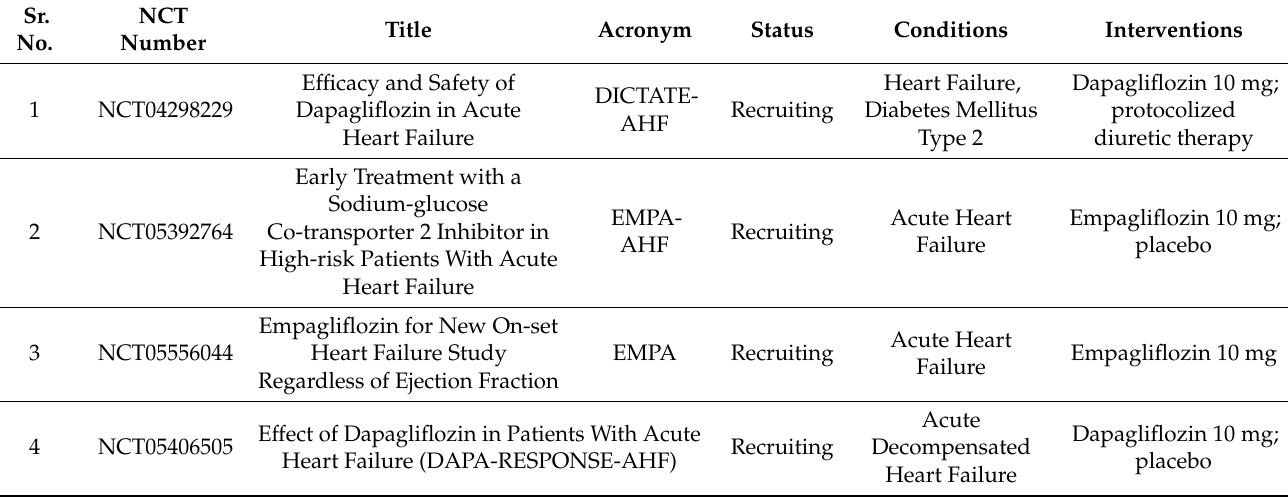
Table 2. Ongoing clinical trial characteristics of SGLT2 inhibitors and varying heart failure